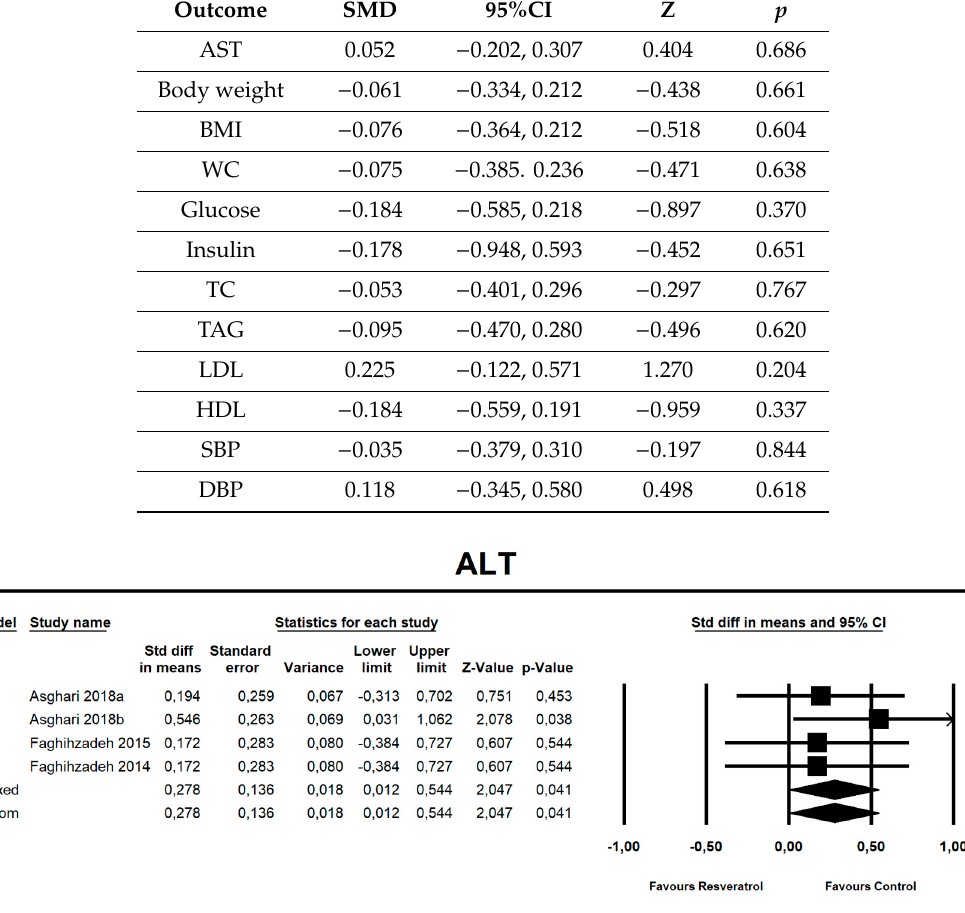
Table 3. The e ff ects sizes, SMD, for co-primary outcomes analyzed in present meta-analysis.